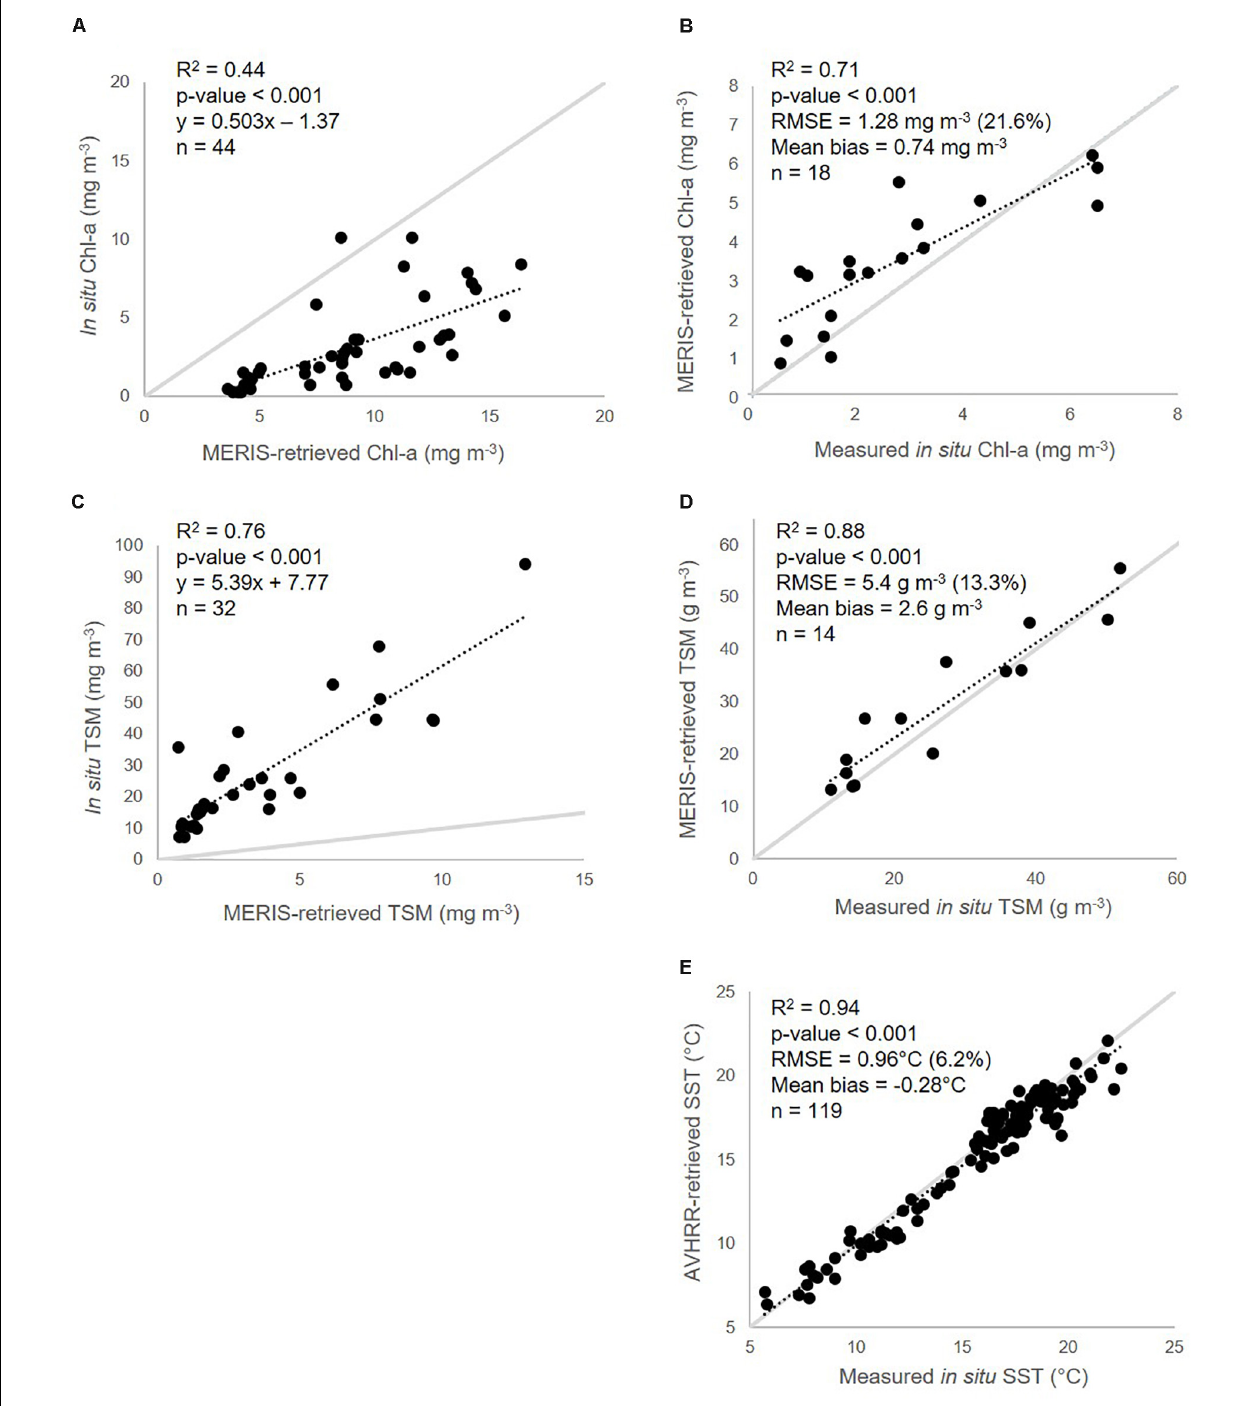
FIGURE 4 | Recalibration (A,C) and validation (B,D) of MERIS OC2 Chl-a (A,B) and Binding et al. (2010) TSM (C,D) retrieval algorithms, and validation of original SST (E) retrieval algorithm calibration, used to drive the DEB model, with corresponding in situ data from Bourgneuf Bay ( Figure 1